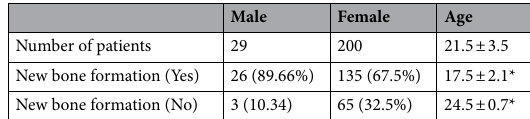
Table 2. Gender and age distribution of patients (*p < 0.05).